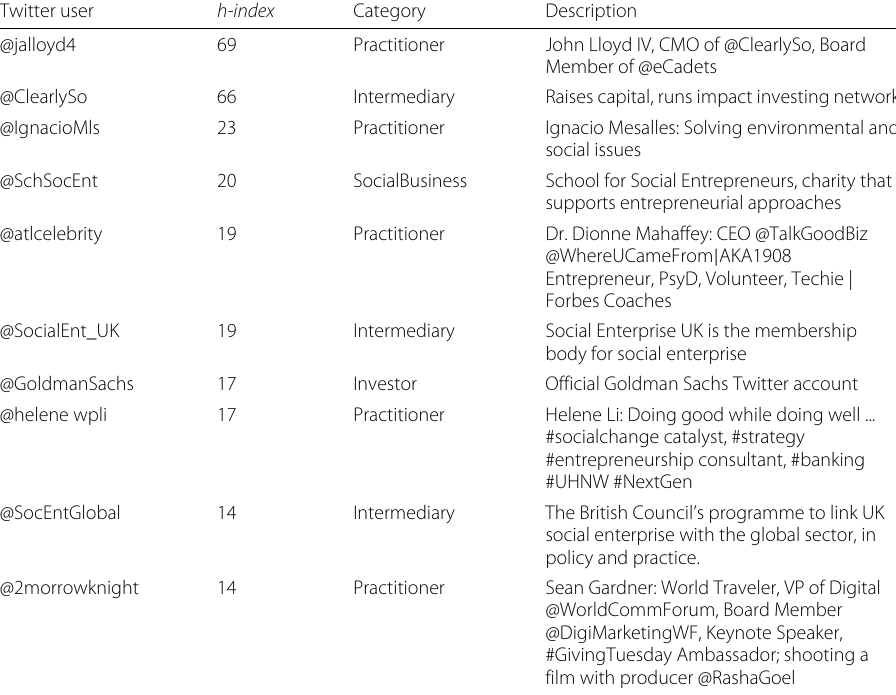
Twitter user h-index Category